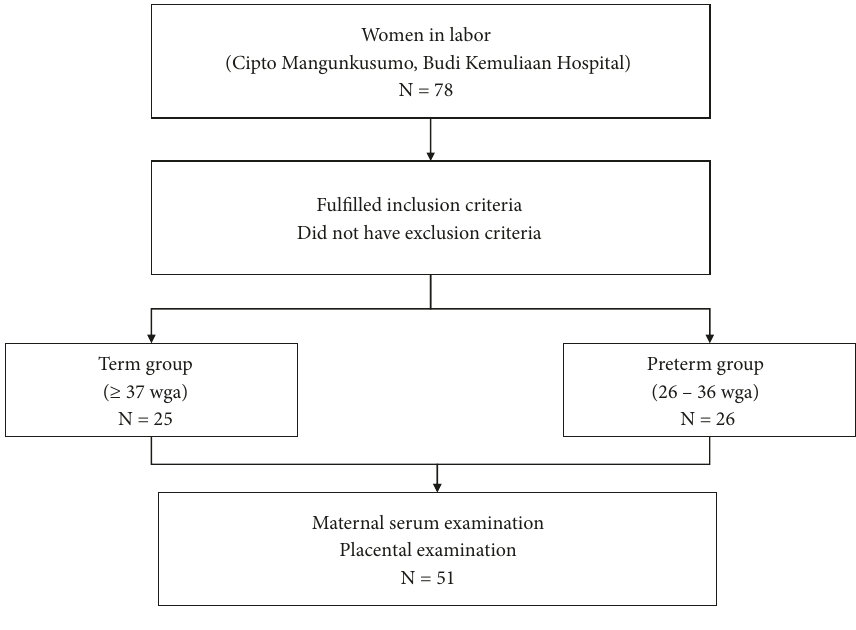
Figure 1: Participants flowchart.